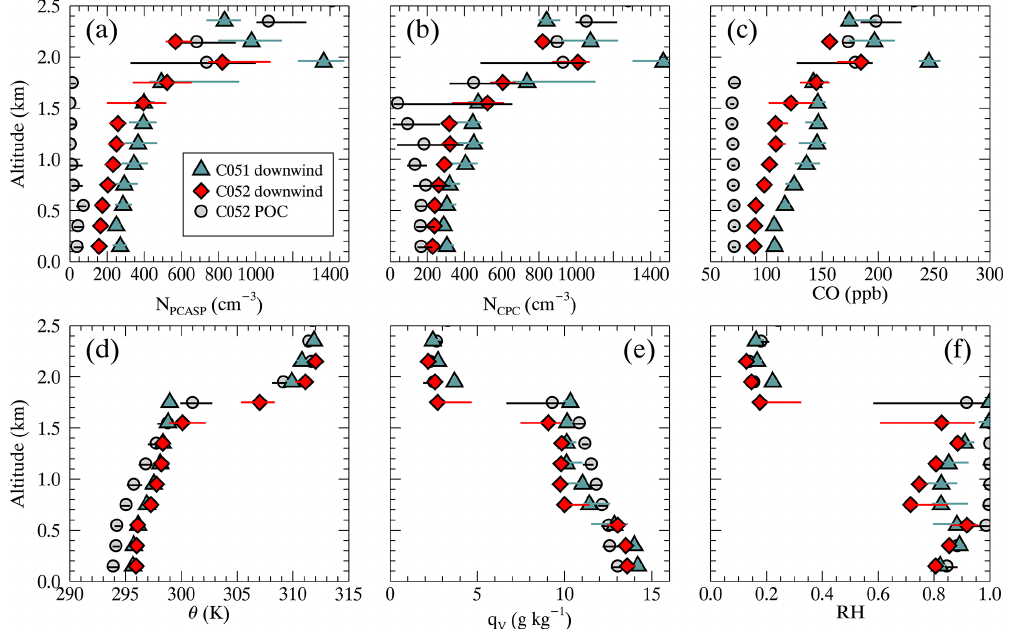
Figure 9. Composite vertical profiles of (a) PCASP number concentration (b) CPC number concentration (c) carbon monoxide (d) potential temperature (e) specific humidity and (f) relative humidity. The filled symbols are the median and the horizontal bars the interquartile range of the data. For flight C052, the data points are from the return low-level leg. The POC is defined as points east of 12 ◦ W and the downwind air mass data to the west of 13 ◦